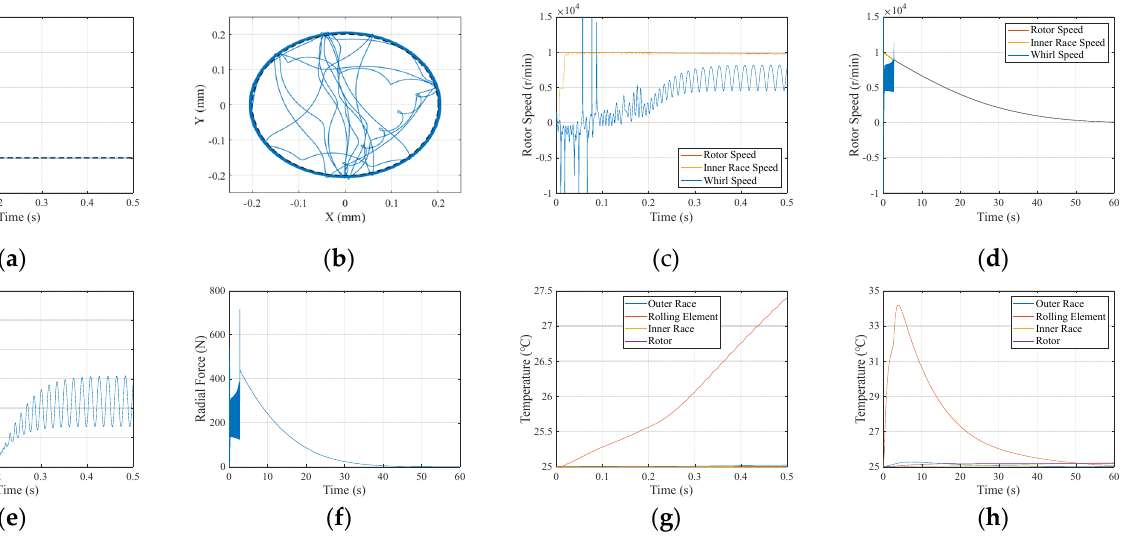
from sub-synchronous whirl to synchronous whirl. The radial maximum contact force was 716 N. The maximum temperature rise of the rolling element was 9.2 °C.